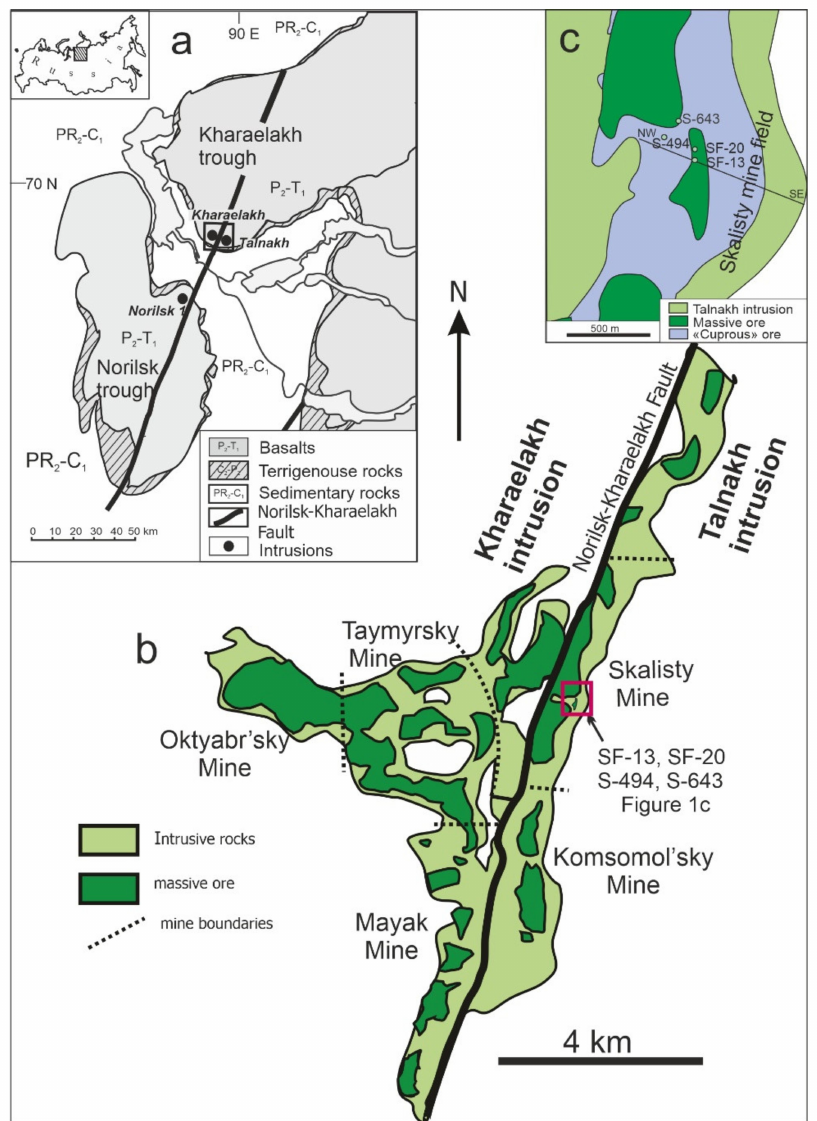
Figure 1. Schematic geological map of the Norilsk–Talnakh district ( a ) and surface projection of the Talnakh and Kharaelakh intrusions modified from [33], including the location of the Skalisty mine ( b ) and the sampling location ( c